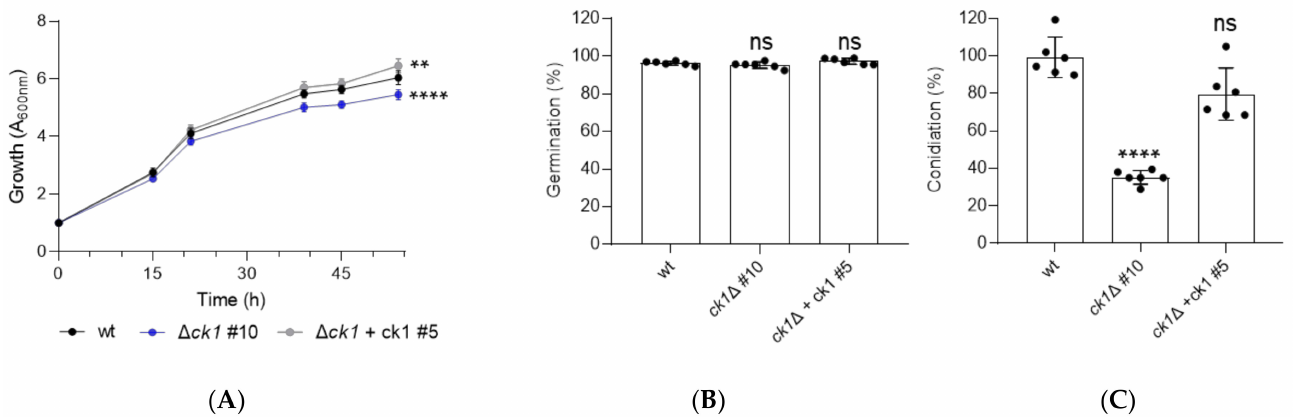
Figure 2. Loss of ck1 severely affects growth and conidiation in a liquid medium . ( A ) Growth of the indicated strains was monitored in microwell plates containing liquid yeast extract ‐ dextrose (YD) medium by measuring absorbance at 600 nm. Values were normalized to time 0. p < 0.01 (**) and p < 0.0001 (****), ns, not significant versus wt, according to Welch’s t ‐ test. Data presented are the mean ±and standard deviation of three replicate microwells from one representative experiment. The ex ‐ periment was performed twice with similar results. ( B ) The percentage of germinated microconidia was determined 15 h after inoculation in PDB medium. ns, not significant versus wt, according to Welch’s t ‐ test. The data presented are the mean and standard deviation of two biological replicates with three technical replicates each. ( C ) Microconidia production by the indicated strains was de ‐ termined after 48 h growth in liquid PDB medium and normalized to the wt strain (100%). p < 0.0001 (****) versus wt, according to Welch’s t ‐ test. The data presented are the mean and standard deviation of two independent experiments with three technical replicates each.